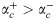
Factual and counterfactual learning biases.(A) Predicted results. Based on previous studies we expected that in Experiment 1 factual learning would display a “positivity” bias (i.e. the learning rate for the chosen positive outcomes would be relatively higher than that of the chosen negative outcomes (αc+>αc−; note that in Experiment 1 the “positivity” and the “confirmation” bias are not discernible). In Experiment 2, one possibility was that this “positivity” bias would extend to counterfactual learning, whereby positive outcomes would be over-weighted regardless of whether the outcome was chosen or unchosen (“valence” bias) (αu+>αu−). Another possibility was that counterfactual learning would present an opposite bias, whereby the learning rate for unchosen negative outcomes was higher than the learning rate of unchosen positive outcomes (αu+<αu−) (“confirmation” bias). (B) Actual results. Learning rate analysis of Experiment 1 data replicated previous findings, demonstrating that factual learning presents a “positivity” bias. Learning rate analysis of Experiment 2 indicated that counterfactual learning was also biased, in a direction that was consistent with a “confirmation” bias. ***P<0.001 and *P<0.05, two-tailed paired t-test.